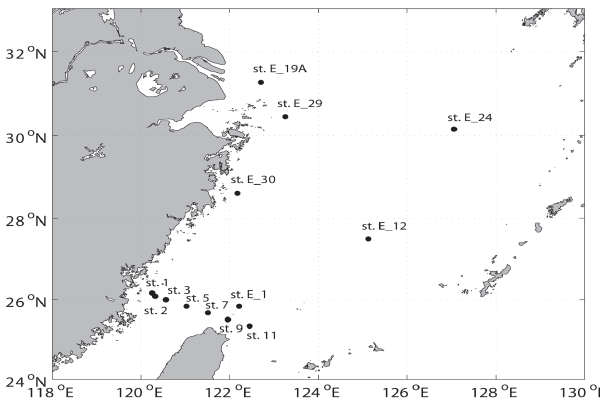
Fig. 1. Map illustrating experimental stations in the East China